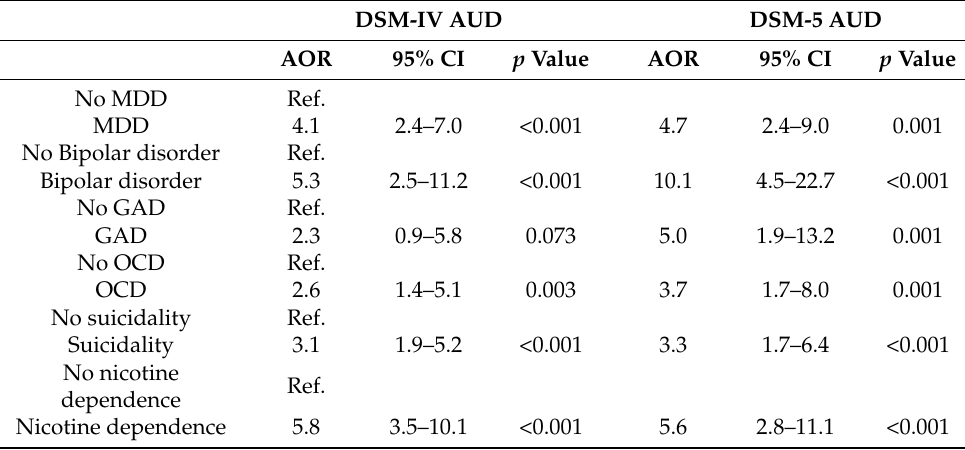
Table 4. Clinical correlates of DSM-IV and DSM-5 alcohol use